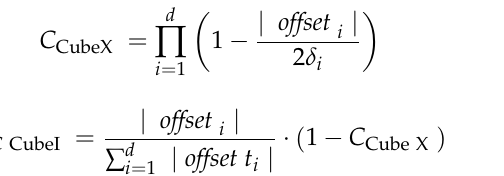
Figure 3. In the original calculation method, the schematic diagram of the contribution of data point P in two-dimensional space.